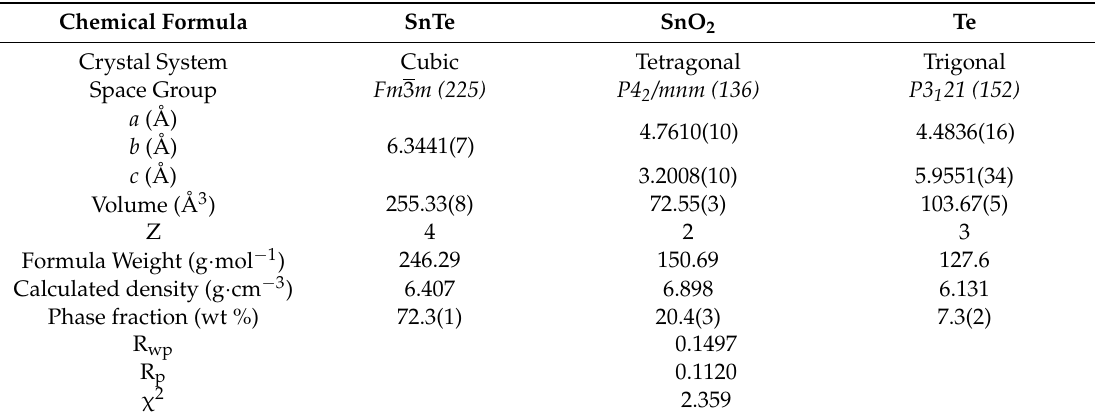
Table 3. Crystallographic data for SnTe